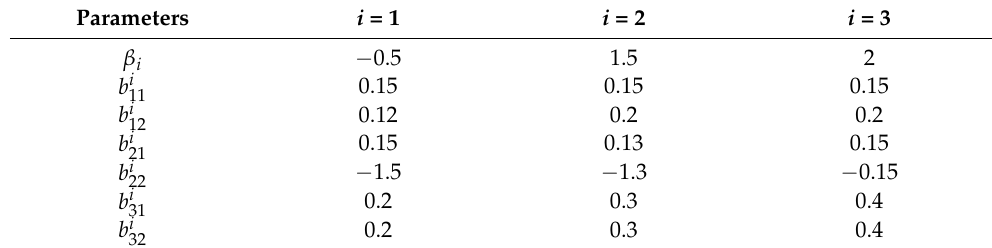
Table 1. Parameters of the F-404 aircraft engine system